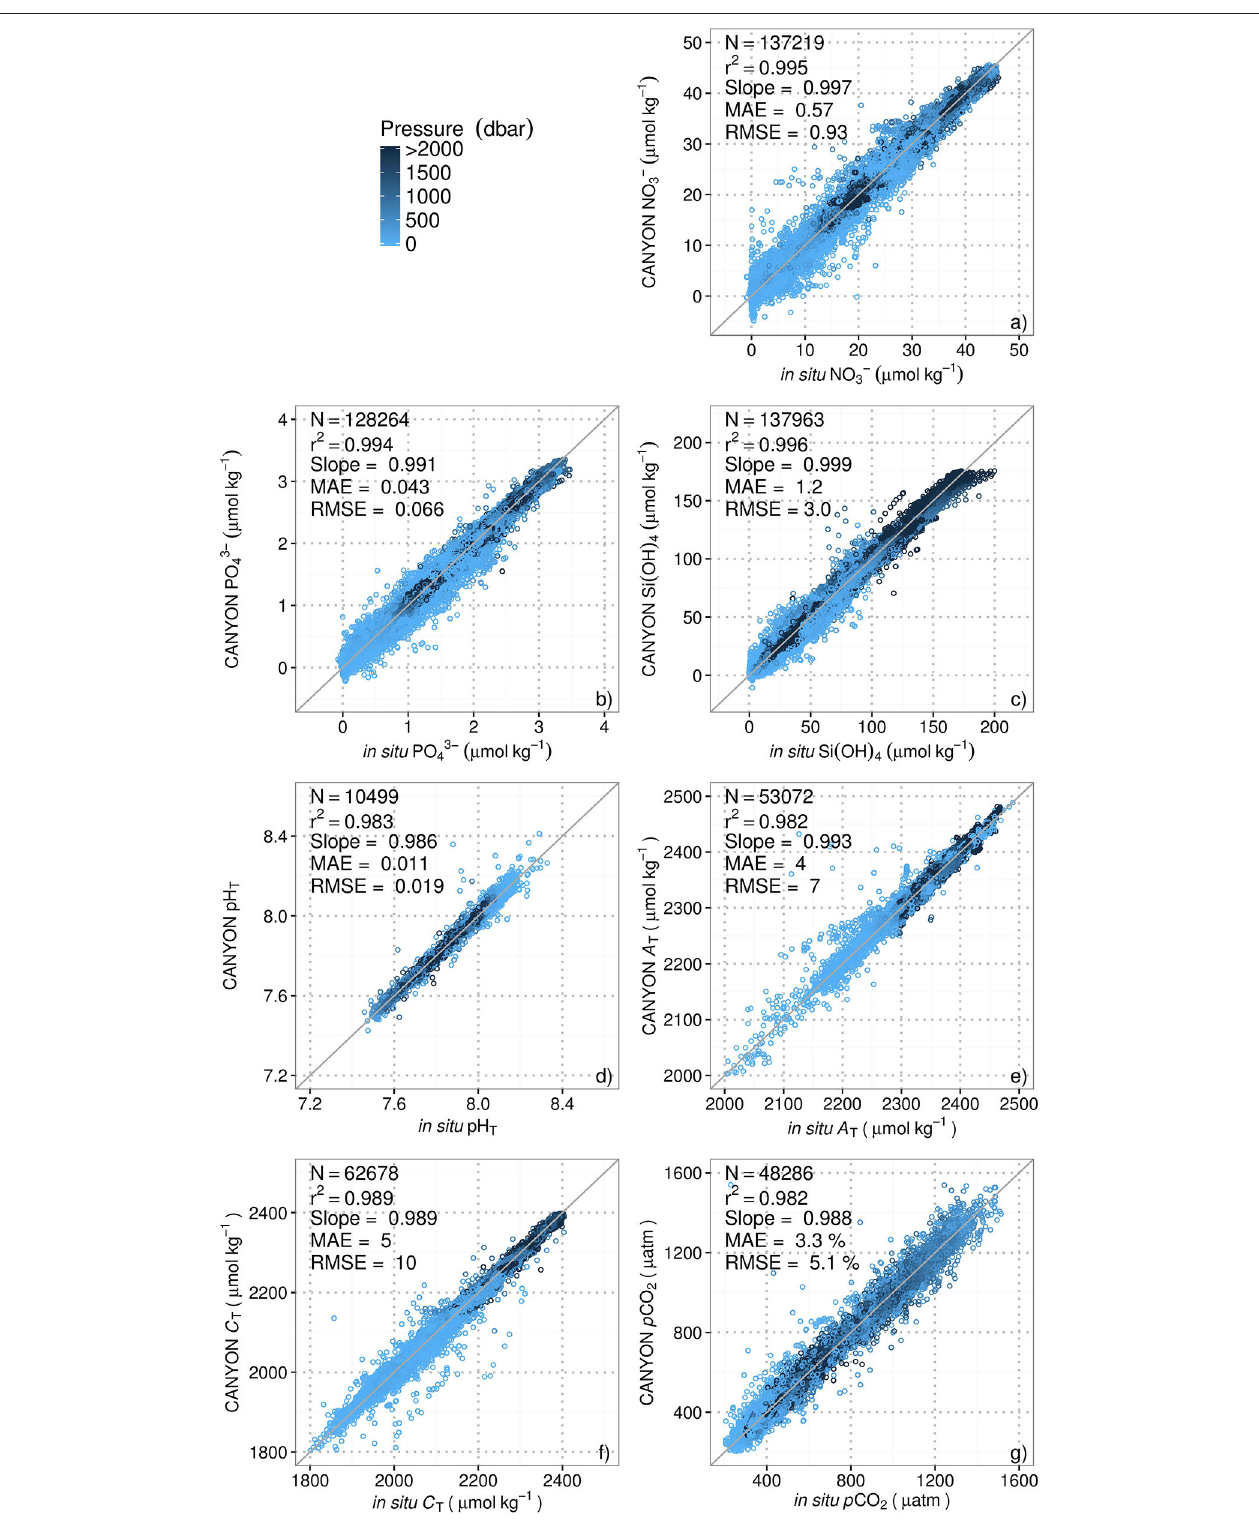
FIGURE 3 | Comparison of the values retrieved by CANYON with the corresponding measurements in the GLODAPv2 database for: (a) NO 3 − ; (b) PO 43 − ; (c) Si(OH) 4 ; (d) pH T ; (e) A T ; (f) C T ; and (g) p CO 2 with data ordered according to the pressure. The 1:1 line is shown in each plot as visual reference. The statistics are defined in Section Statistical Evaluation of Method Performance.